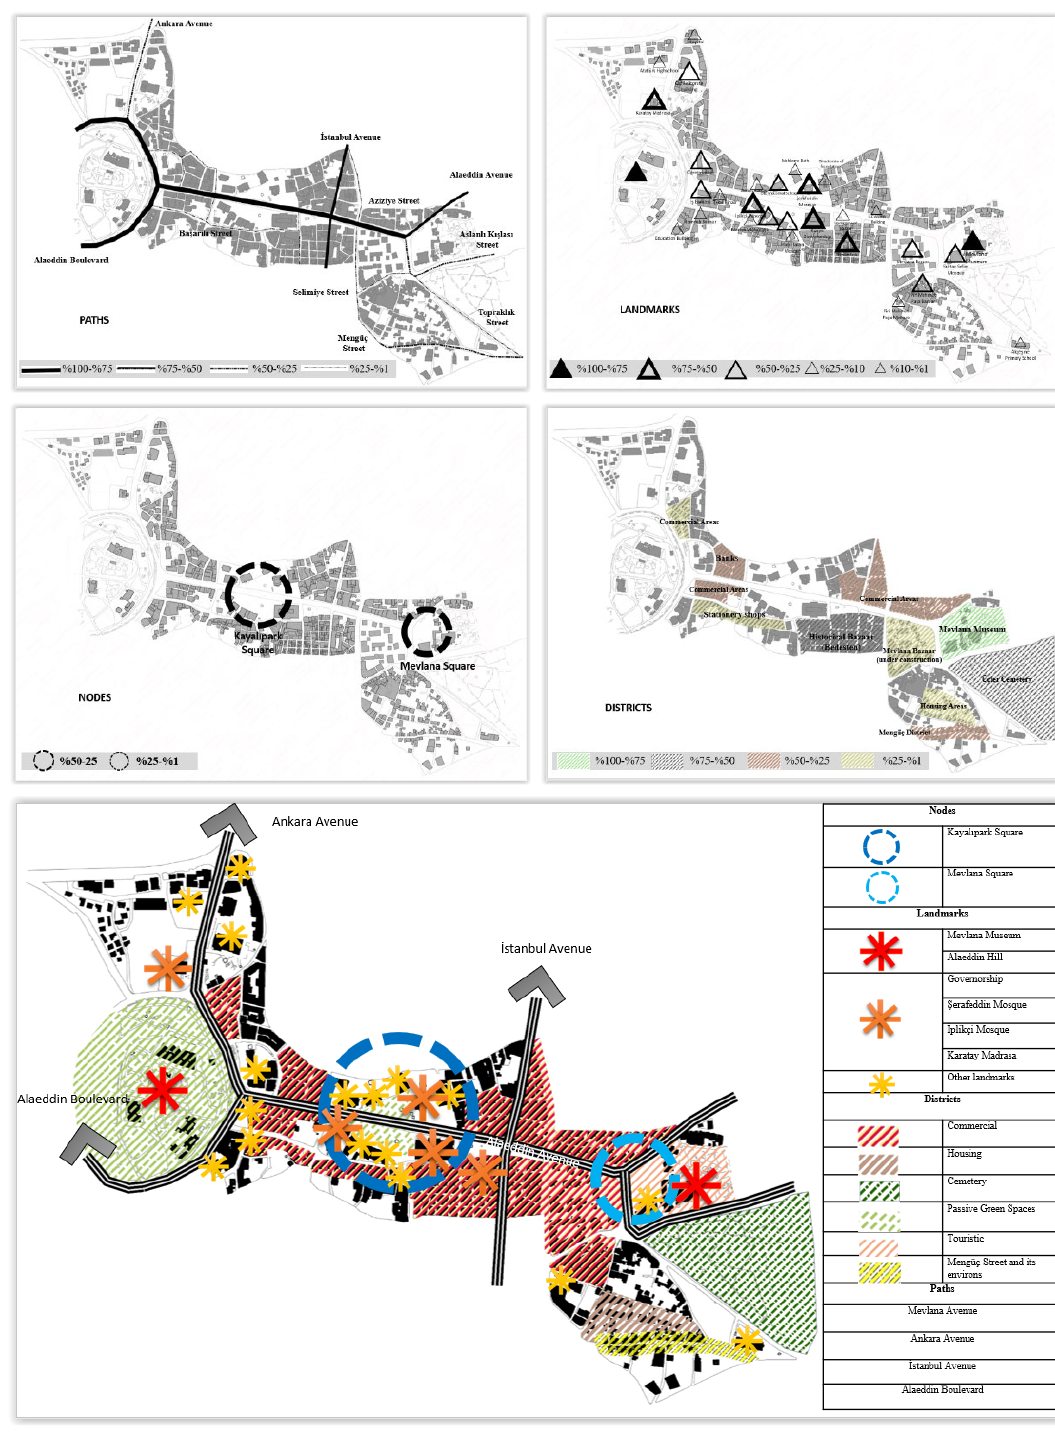
Figure 20 The cumulative cognitive map of all participants for the sample area (Ünal,